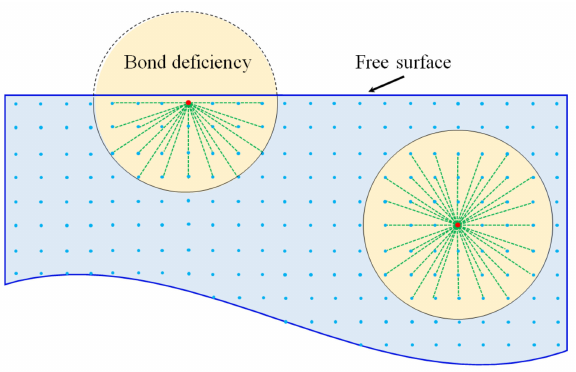
Figure 6. Bond deficiency for the material points close to the free